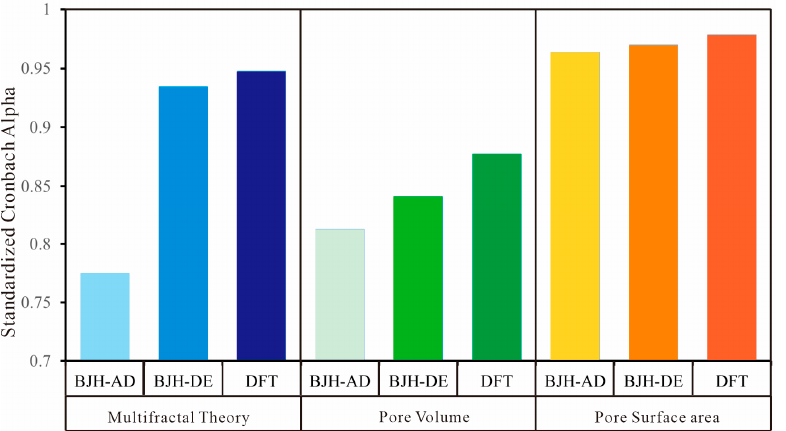
Figure 14. Calculation of Cronbach’s alpha bar chart for the multifractal parameter, PV, and SA.